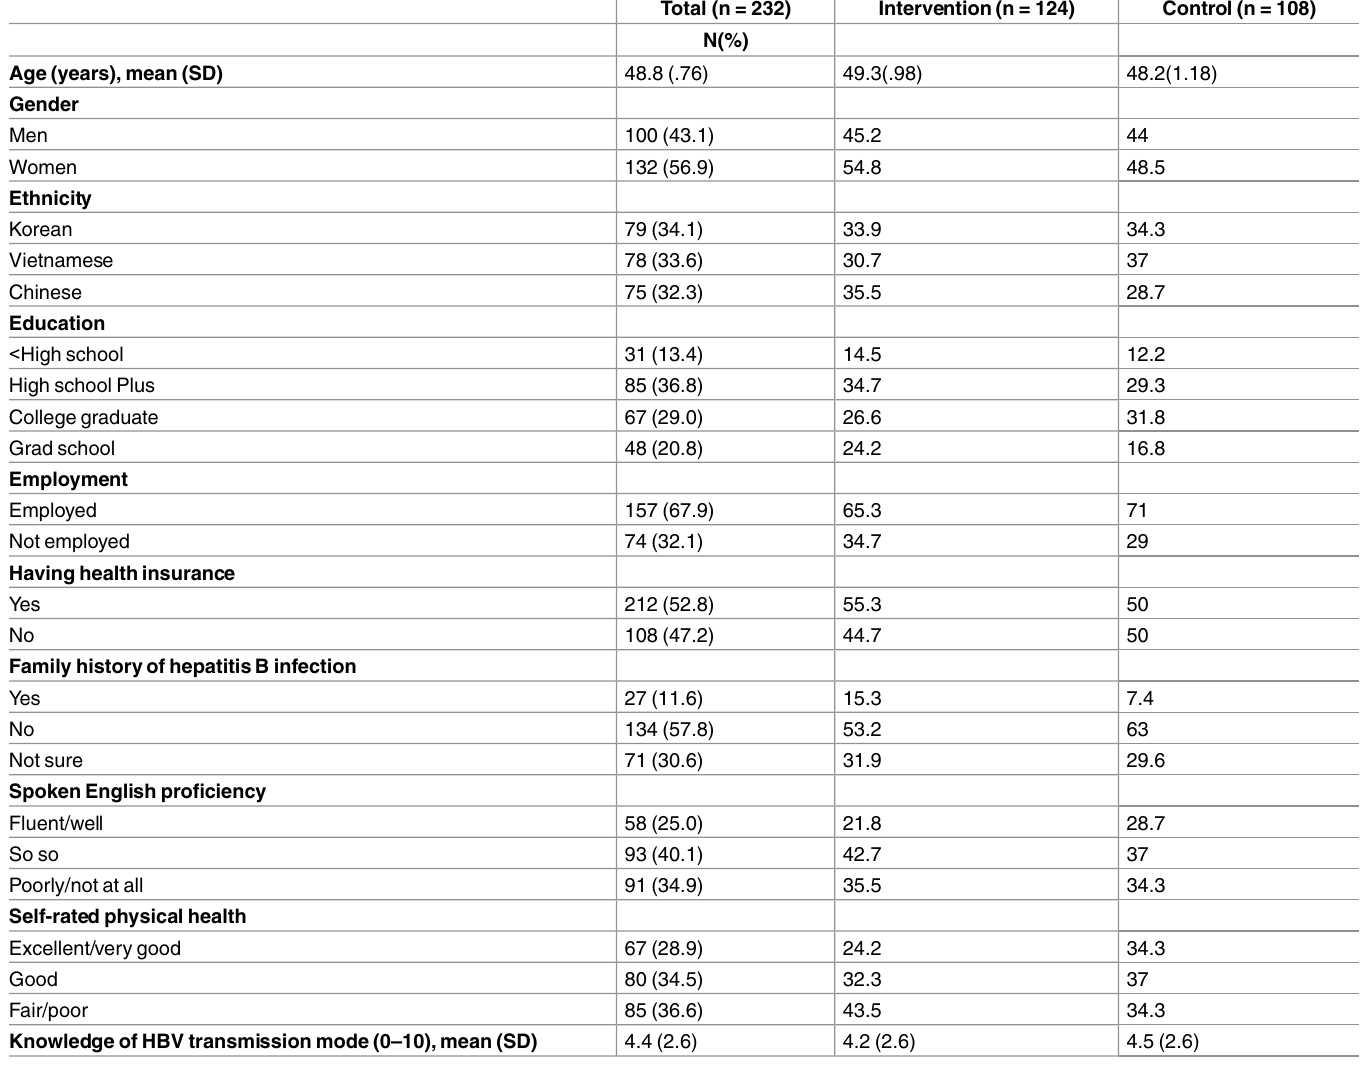
Table 1. Baselinecharacteristicsin the BaltimoreWashington Metropolitan Area, 2013–2014 (n =